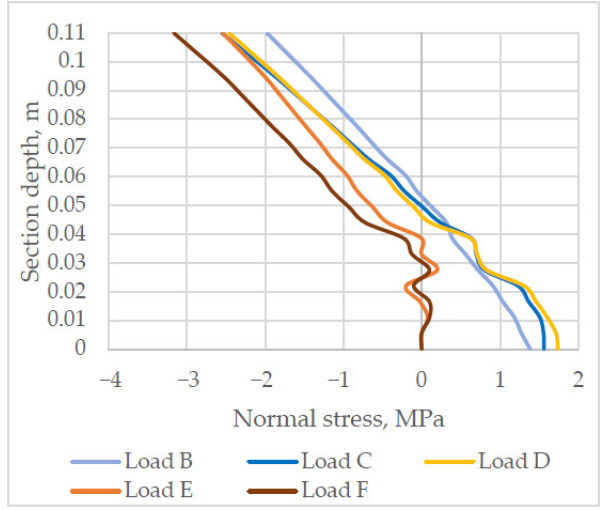
Figure 12. Stress distribution in the normal section of the support zone (negative stress values = compression).